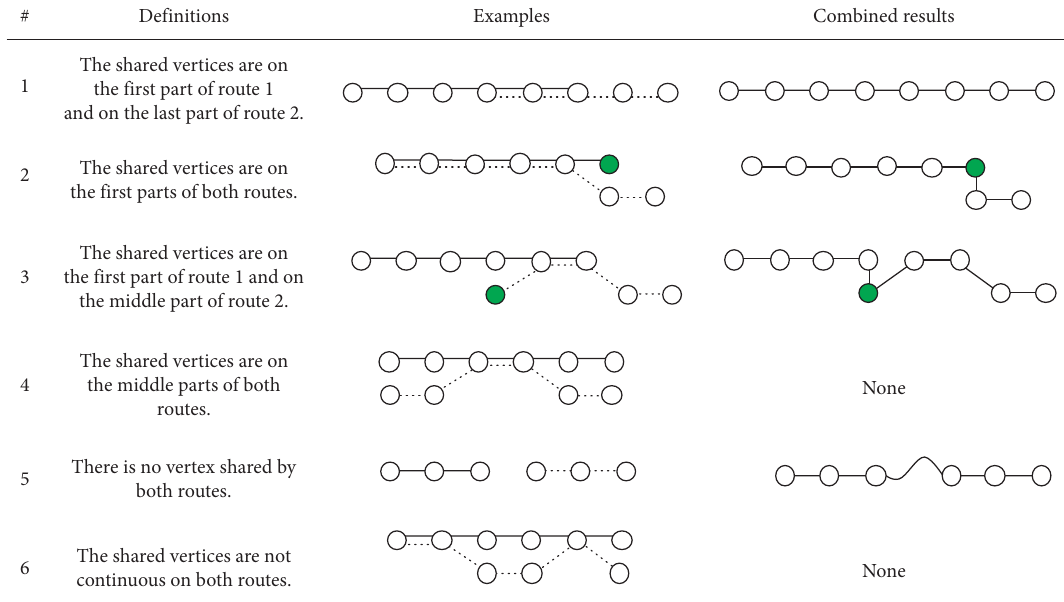
Figure 4: Six kinds of route relationships and their corresponding combined results.